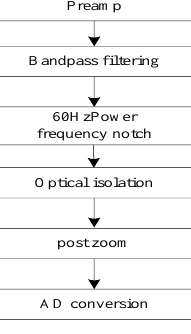
Figure 4. Structure diagram of ECG